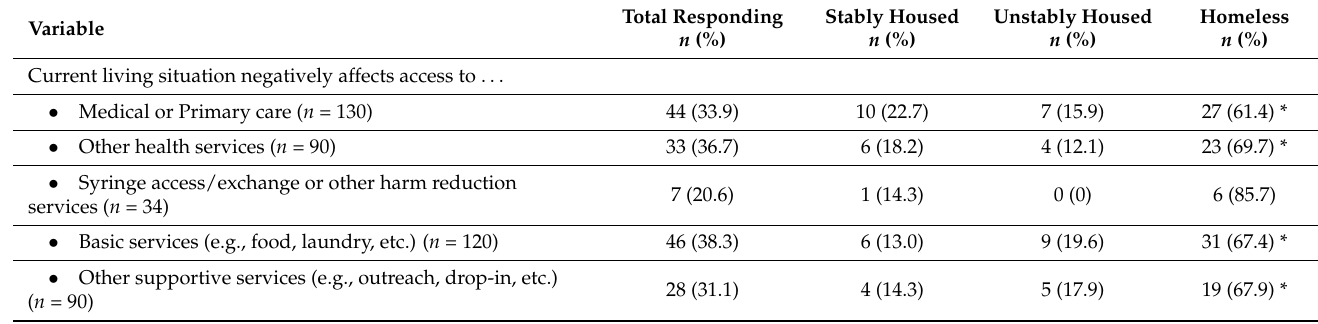
Table 4. Access to services among participants according to housing